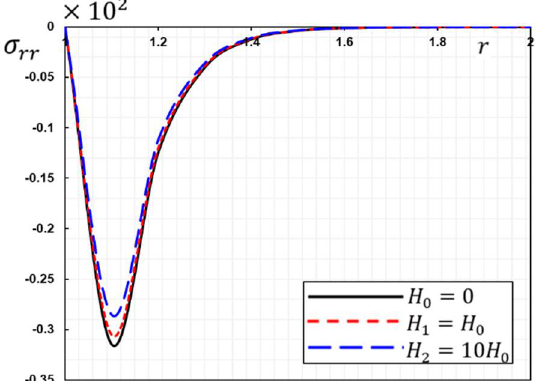
Figure 4. The radial thermal stress, σ rr , versus the axial magnetic field, H 0